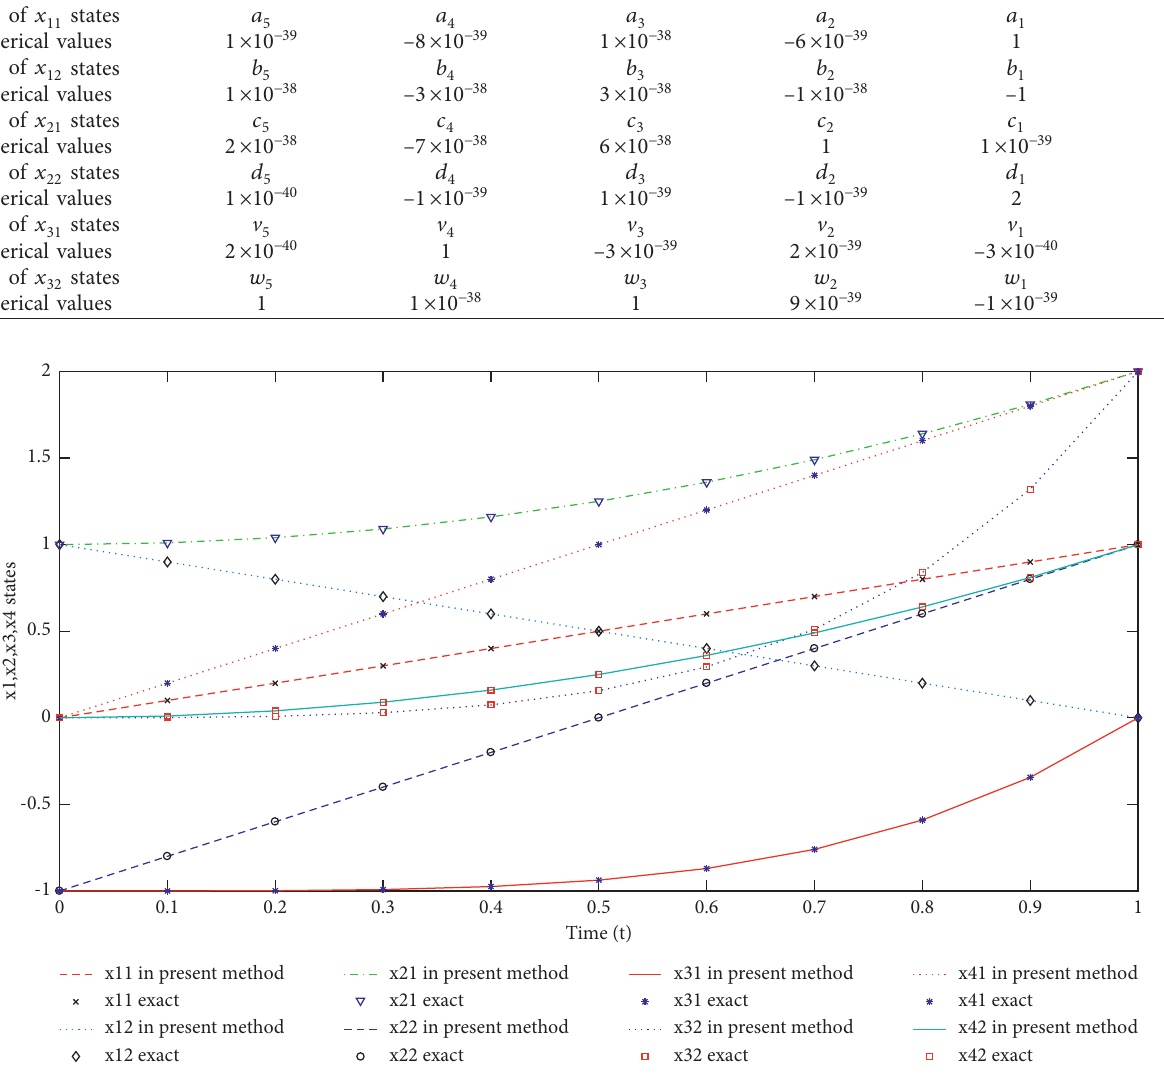
Table 1: Unknown coefficients of the representation of x